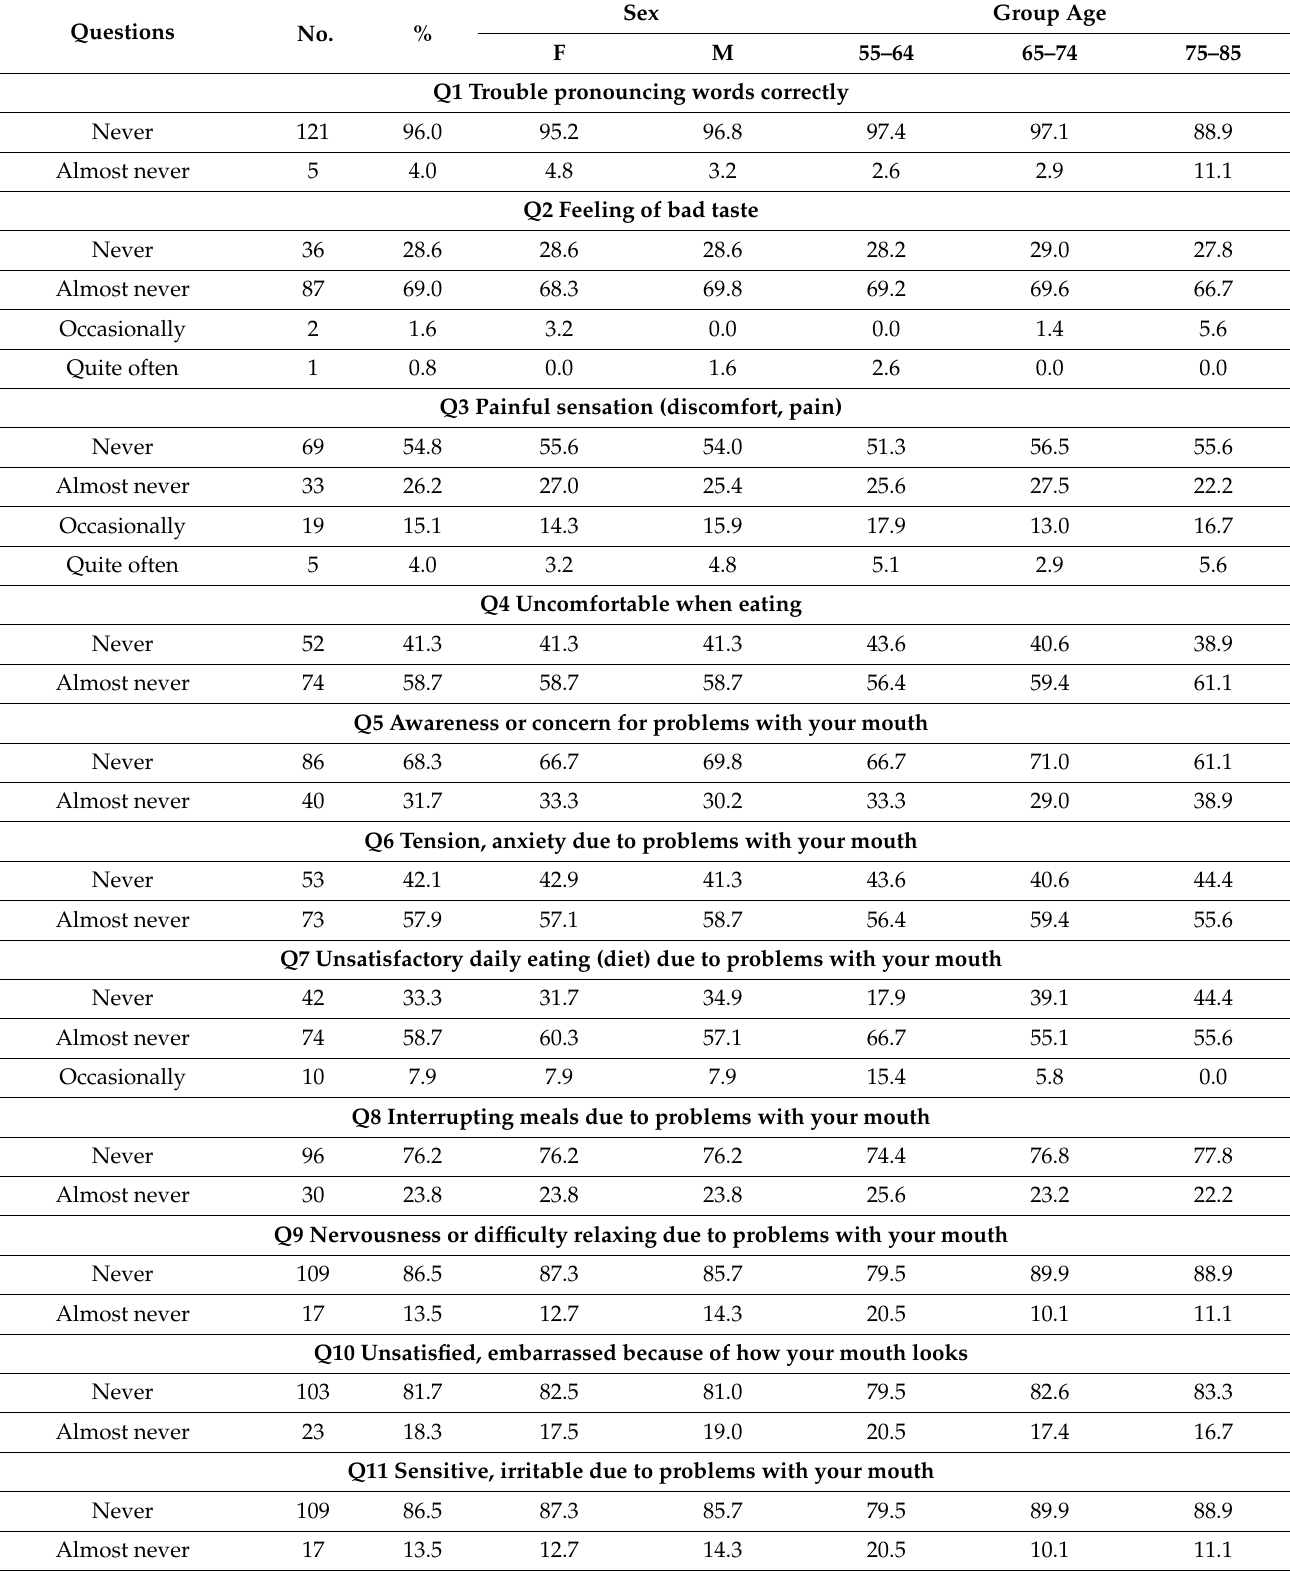
Table 4. Distribution of the answers to the OHIP questionnaire for the wearers of dentures with